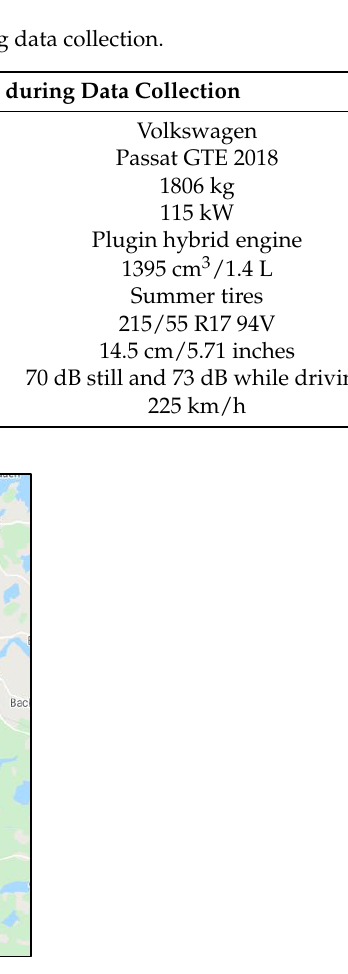
Figure 3. Map showing the trip where data collection took place on gravel roads on the outskirts of Borlänge and in Skenshyttan, Sweden.